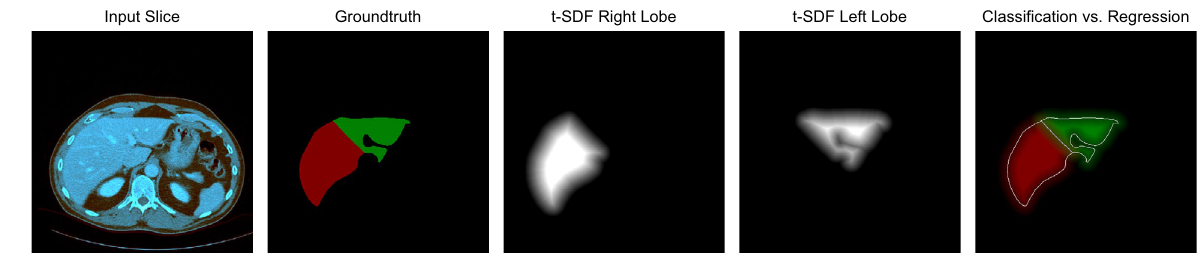
Figure 3. A multi-class segmentation converted to a truncated Signed Distance Field (t-SDF) for an auxiliary regression task. The right hand image shows the difference between the classification and regression boundary. For t-SDF regression, the network is forced to learn more about the spatial